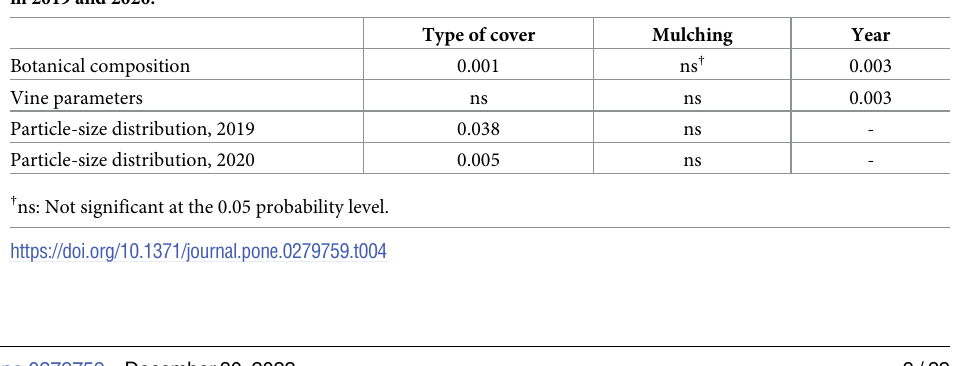
Table 4. Statistical significances based on a permutation test of the effects of type of inter-row vegetation, mulch- ing and year on inter-row botanical composition, vine parameters and runoff sediment particle-size distribution in 2019 and